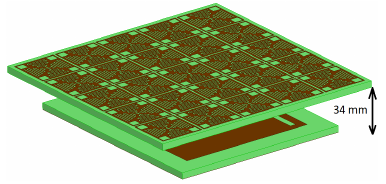
Figure 9. Arrangement of the antenna and the superstrate.